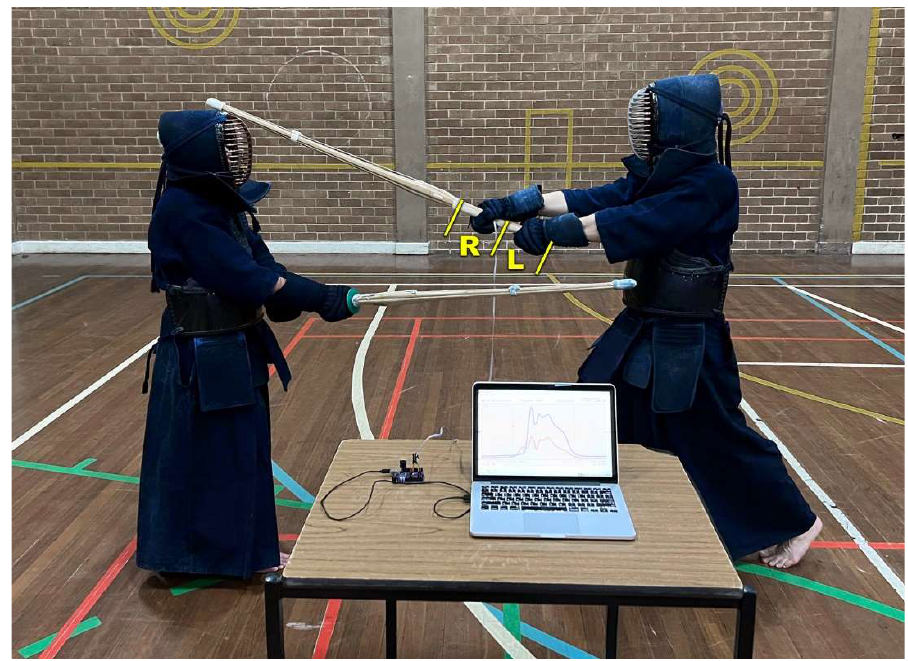
Figure 2. Experimental setup for testing the grip force with Smart Shinai (Men-bu, head target); L = pressure sensor of left hand, R = pressure sensor of right hand.